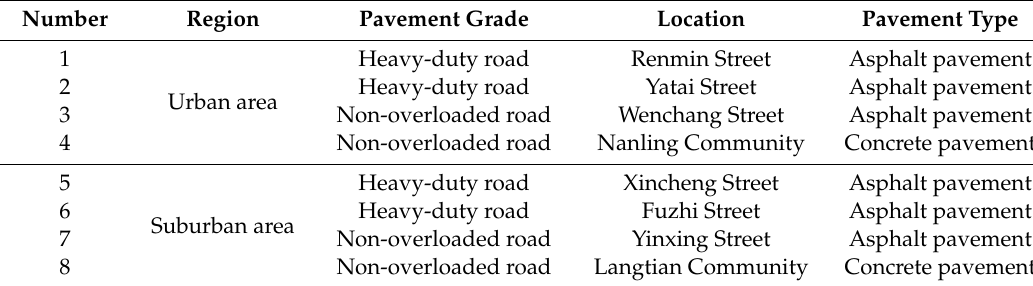
Table 6. Clogging materials collection locations.